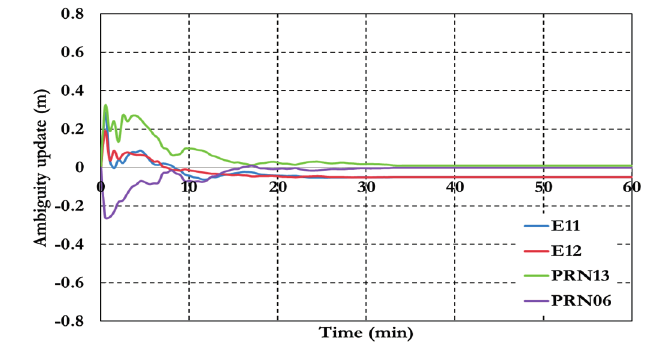
Figure 7. Postioining results of the traditional GPS/Galileo PPP model.